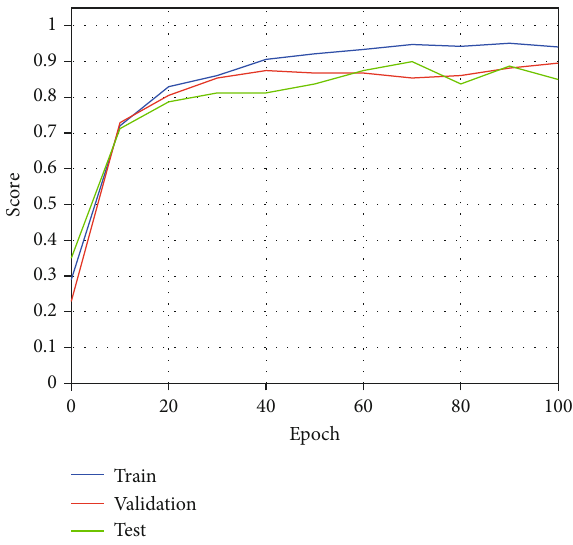
Figure 11: Accuracy scores of the CNN for the data arrangement in Figure